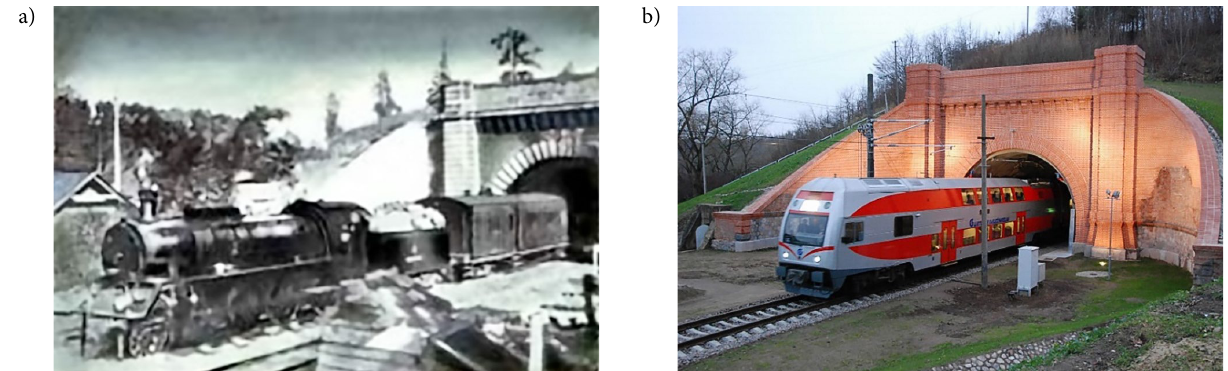
Figure 4. Kaunas tunnel (photos by Lithuanian Railway Museum): a – train near Kaunas tunnel, interwar